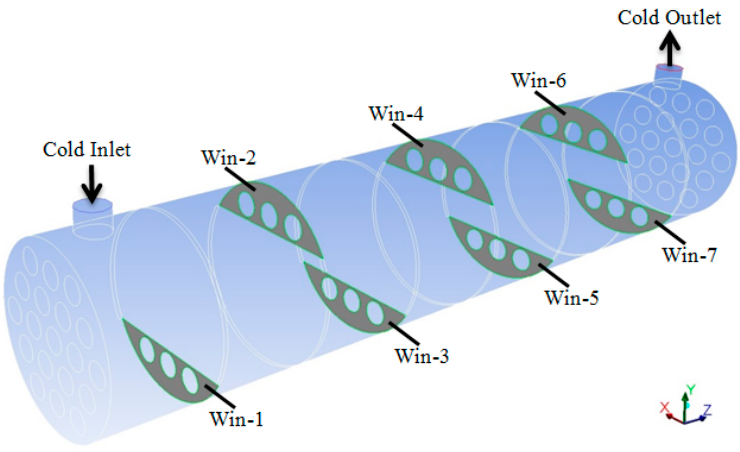
Figure 9. Window surfaces located between two adjacent fluid zones.